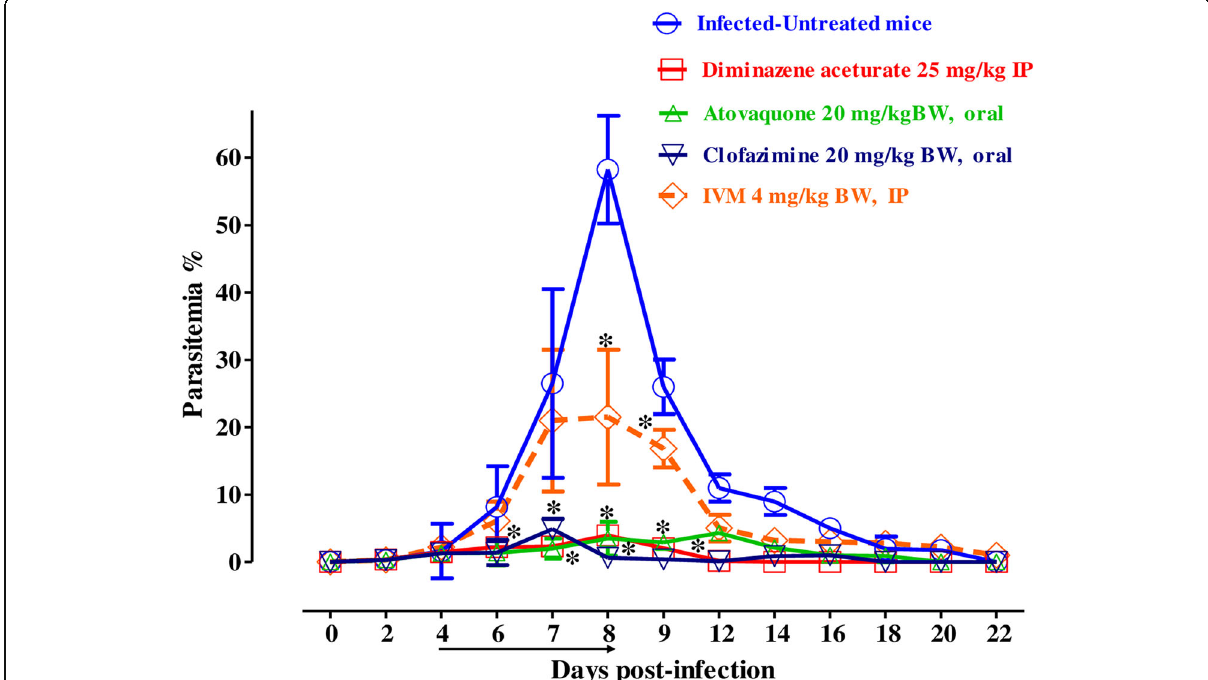
Fig. 3 The growth inhibition of IVM on B . microti in vivo . Graph showing the inhibitory effects of DA-IP, AQ-oral, CF-oral, IVM-IP treatment as compared to the untreated group. The values plotted indicate the mean ± standard deviation for two separate experiments. Asterisks (*) indicate statistical significance ( p < 0.05) based on one-way ANOVA Tukey ’ s test using GraphPad Prism version 5.0 for Windows (GraphPad Software Inc., San Diego, CA, USA). The arrow indicates five consecutive days of treatment. Parasitemia was calculated by counting infected RBCs among 2000 RBCs using Giemsa-stained thin blood